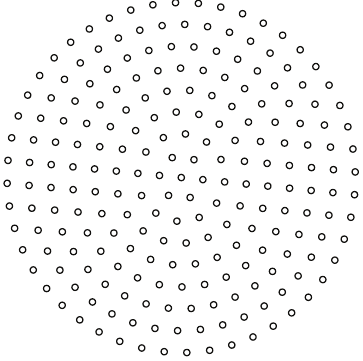
Figure 2: Arrangements of Lagrangian points.